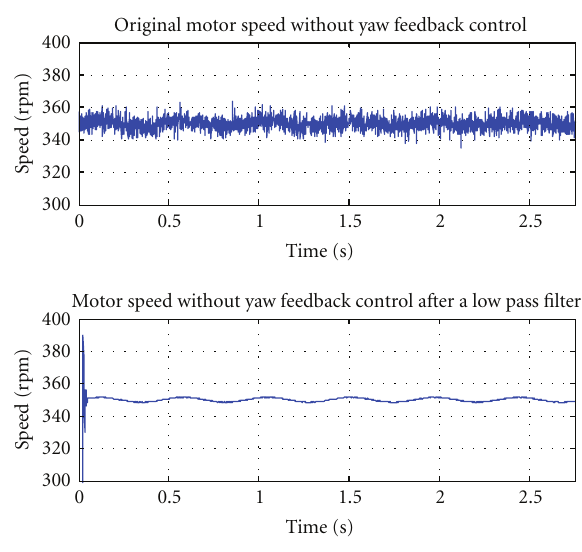
Figure 9: A comparison between simulated and experimental results for a free running wheel motor.